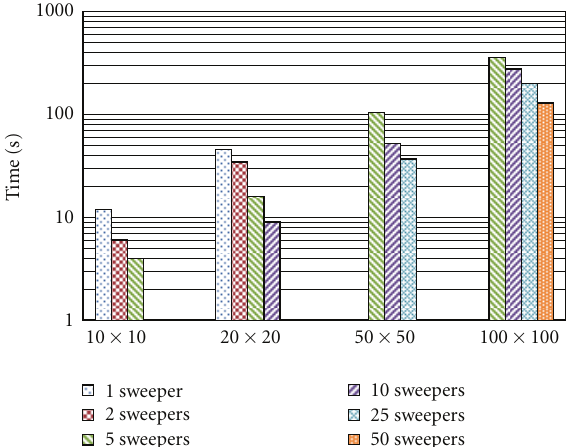
Figure 8: Time in fully coordinated motion.